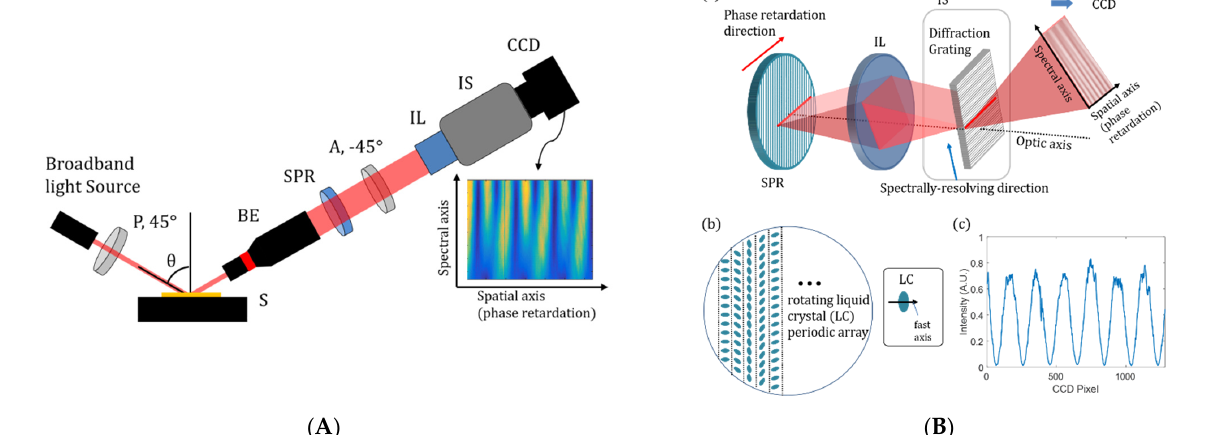
Figure 5. ( A ) Schematic of spatially phase-retarded spectroscopic ellipsometry and ( B ) operating principle of spatial phase retarder (sub-panels: ( a ) acquisition of the single image containing intensity variations corresponding to polarization changes and wavelengths, ( b ) depolarizer based on a rotating LC array as a SPR, and ( c ) intensity variation of linearly polarized light by SPR) (reprinted/adapted with permission from [37] © The Optical Society); P, polarizer; S, specimen; BE, beam expander; SPR, spatial phase retardation plate; A, analyzer; IL, imaging lens; IS, imaging spectrometer.